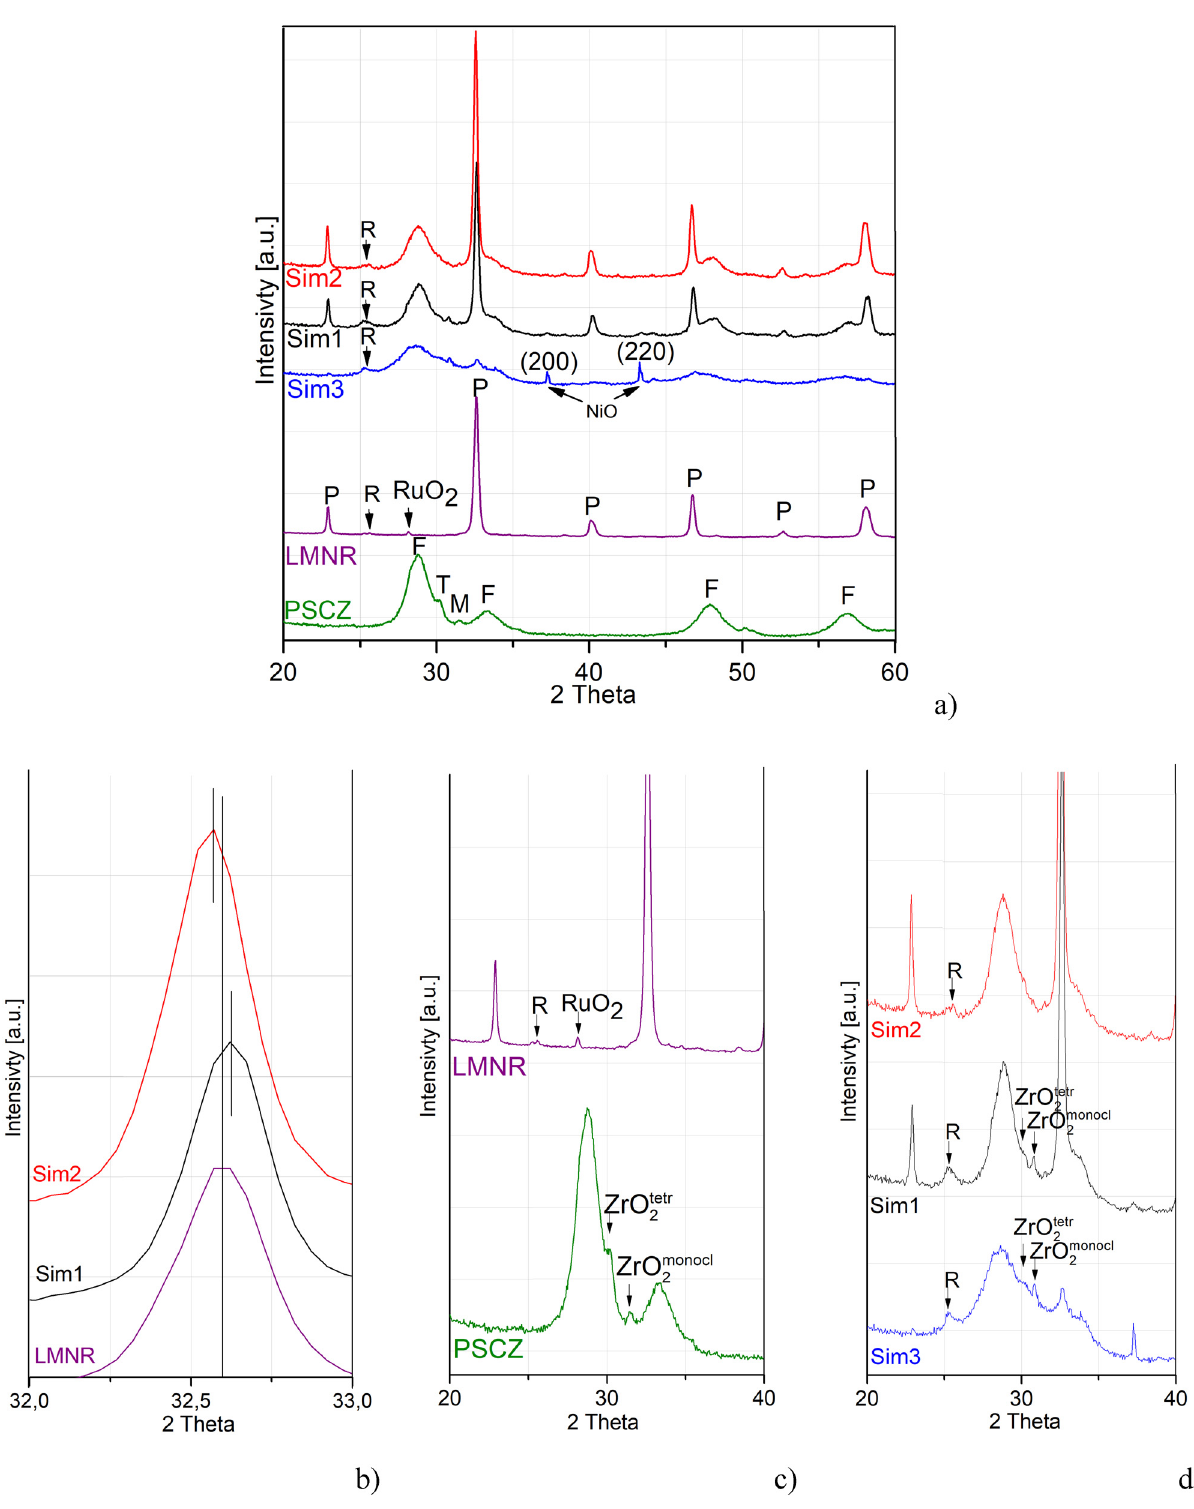
Figure 1: XRD patterns of as - prepared samples. ( a ) Total patterns and ( b – d ) their enlarged fragments. P – perovskite phase, F – fl uorite phase, R – Ruddlesden - Popper phase, M – monoclinic zirconia phase, T – tetragonal zirconia